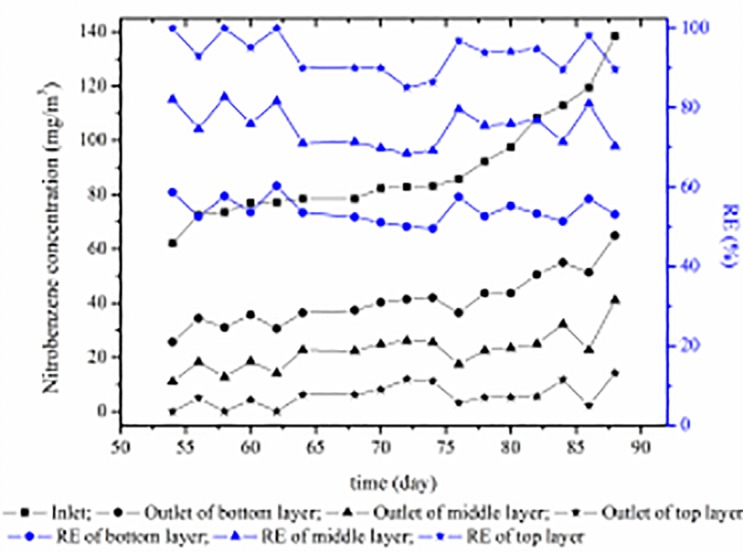
Outlet concentrations of NB and REs in different layers with an EBRT of 55.4 s.